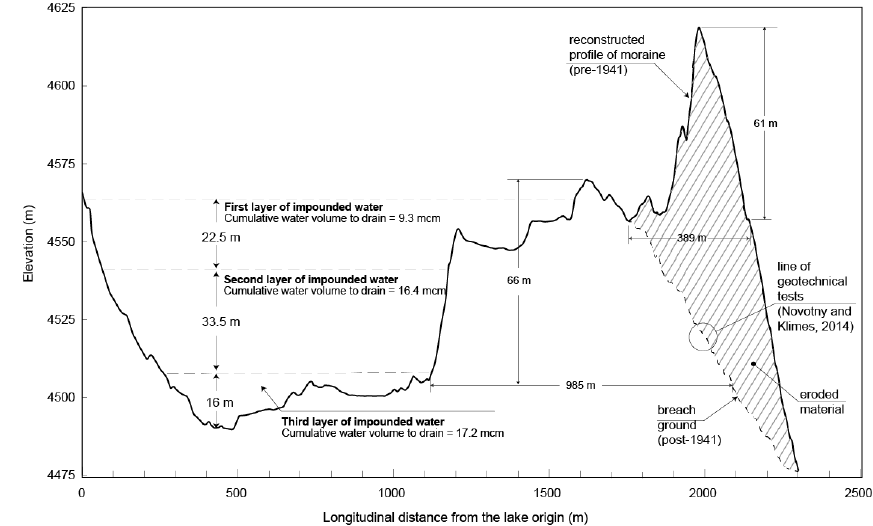
Figure 3. Palcacocha Lake and moraine longitudinal profile revealing differences between the post-1941 current moraine and a reconstruction of the moraine profile before 1941 (projected from non-breached adjacent portions of the end moraine).